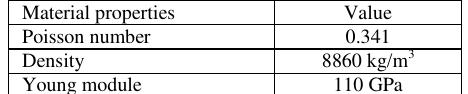
Table 2. Ti-3Al-8V-6Cr-4Mo-4Zr Beta C (TM) material properties used for calculations